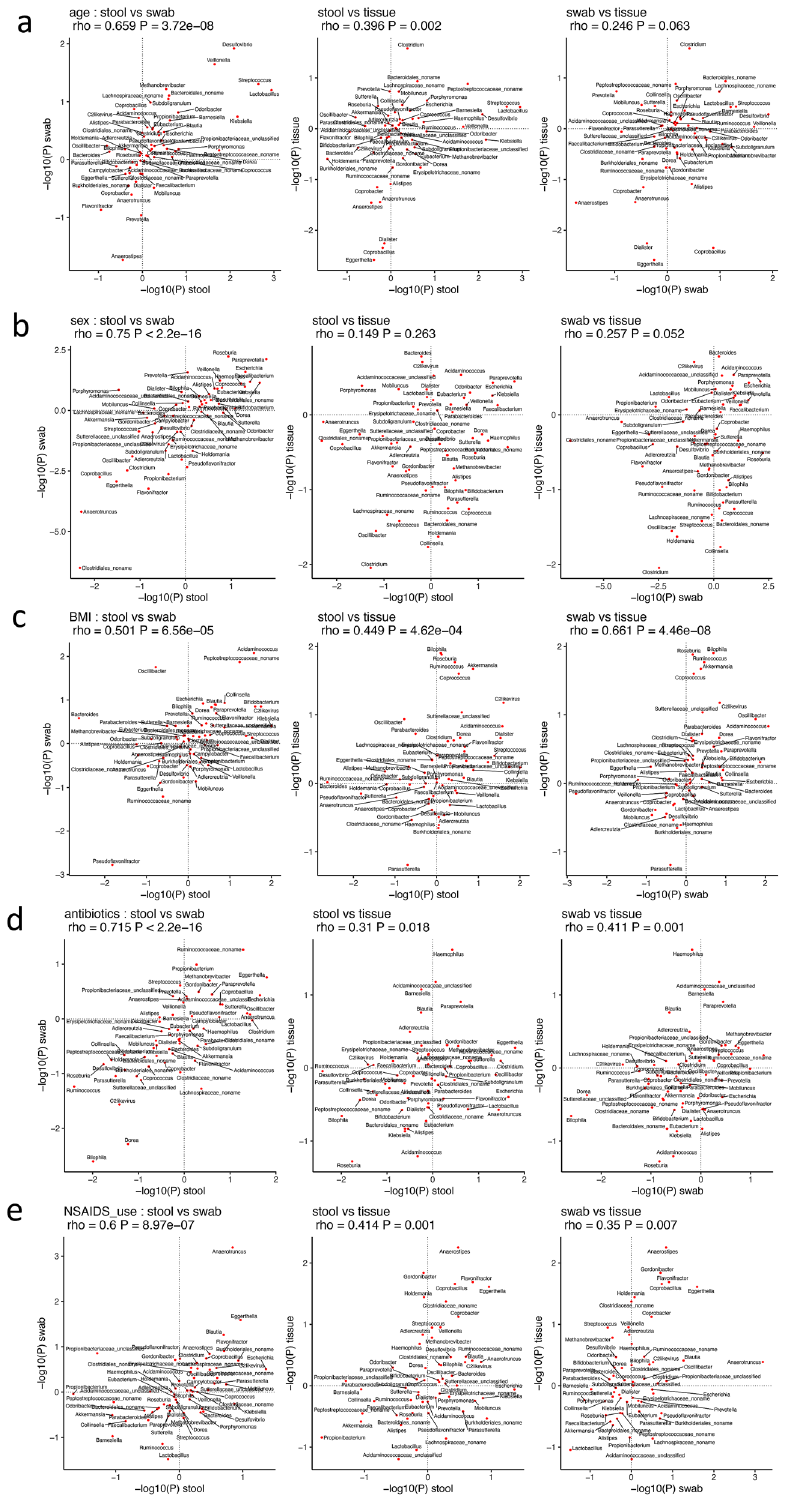
Figure 5. Correlations between the genus level composition inference for age (a) , sex (b) , BMI (c) , antibiotics use (d) and NSAIDs use (e) between pairwise sample types. The axes showed the p-values that were log10 transformed and multiplied by + 1/−1 to include the direction of changes from the model 2 described in